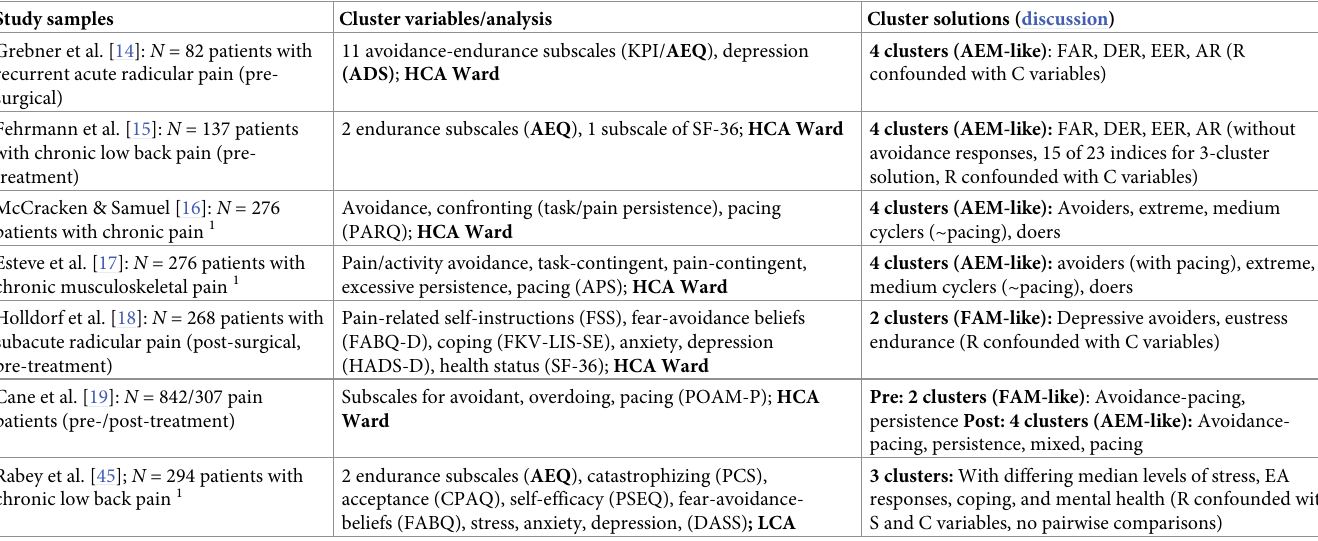
Table 1. Overview of cluster-analytical studies based on pain-related avoidance-endurance responses. Study samples Cluster variables/analysis Cluster solutions